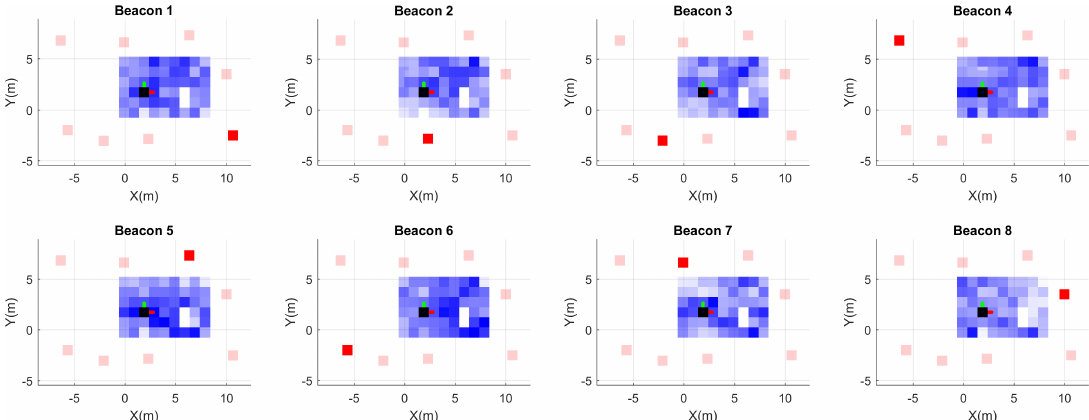
Figure 13. Voxel 3D maps for each beacon (anchor). The gradient in the color represents the s 2 level in the voxel, 1m spatial resolution; the reference beacon for the map is in dark red.